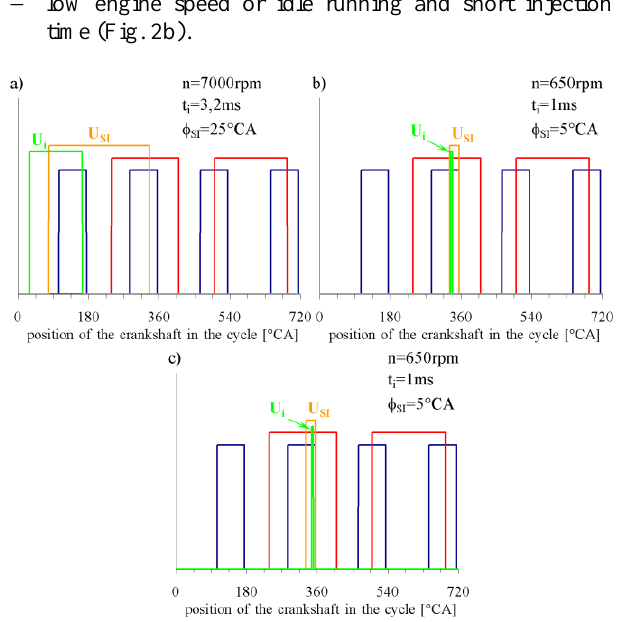
Fig. 2. Waveforms in situations giving rise to doubts as to the unambiguity of the assessment of the fuel-air mixture type If the simultaneous occurrence of injection and ignition pulses is treated as a state indicating the formation of a stratified mixture, the waveforms in Fig. 2a misrepresent the formation of a stratified mixture. It is obvious that at high revs the engine is powered by a homogeneous